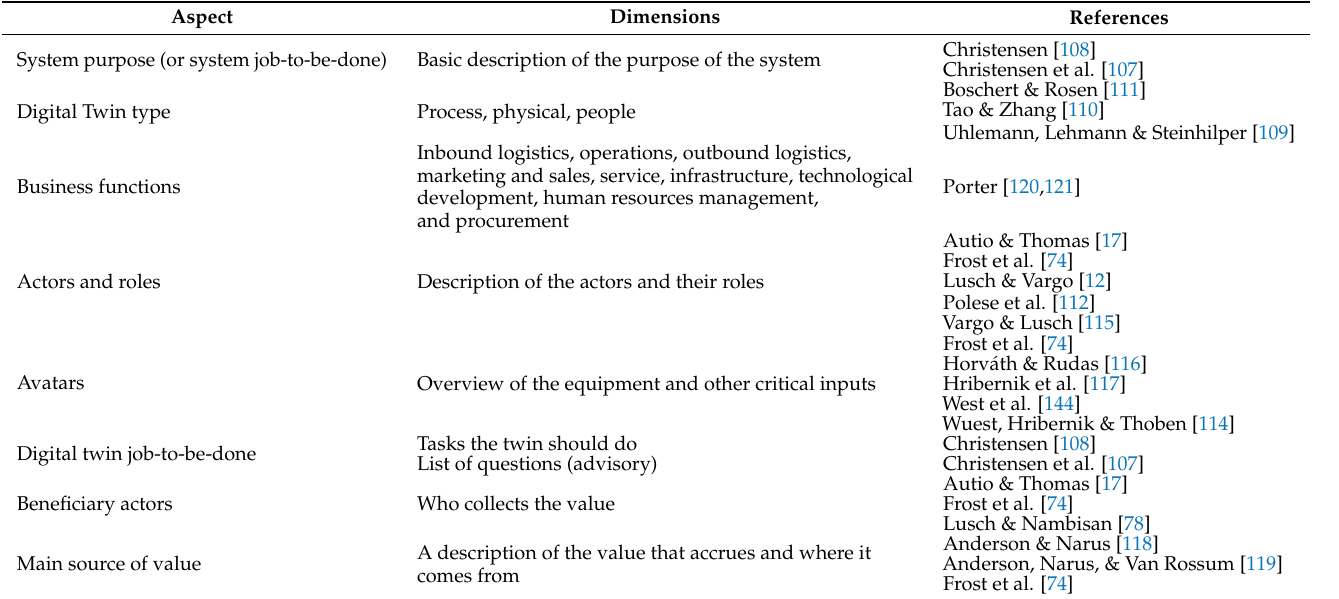
Table A2. Basic case descriptions.